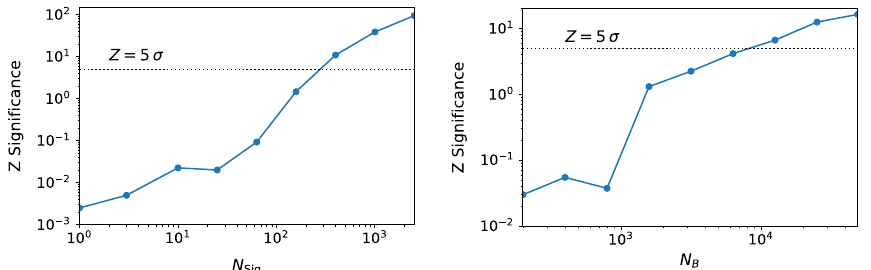
the right figure, N T = N B + N sig , where N sig varies in proportion to N B and the relative signal/background cross-sections. In both cases, we use the trial sample T 2 corresponding to the signal with M med = 2